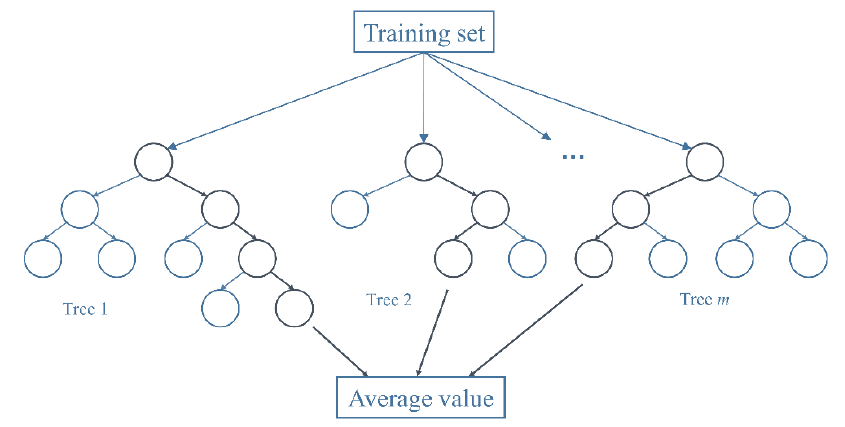
Figure 6. Random Forest model.